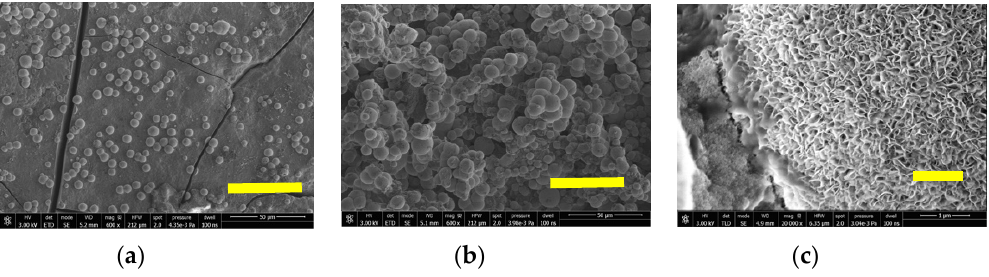
Figure 8. SEM micrographs of SCS8 aerogel after two weeks ( a ) and four weeks ( b ) immersion in SBF, right bottom bar 50 μ m. Micrograph ( c ) shows details of the needle-like surface crystallites that form the spherulite, right bottom bar 1 μ m.